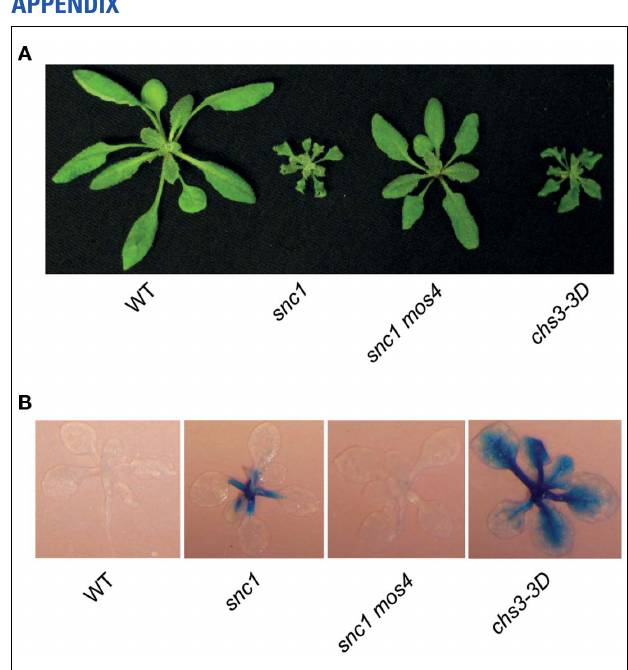
FIGUREA1 | Characterization of chs3-3D . (A) Morphology ofWT, snc1 , snc1 mos4 , and chs3-3D soil-grown plants. Representative plants were photographed 4weeks after germination. (B) Expression of the pPR2 - GUS reporter gene, present inWT and snc1 mutant background, in the above-mentioned genotypes. Seedlings were grown on MS media for 14days prior to staining for GUS activity.The three photographs shown were taken at different magnifications in order to effectively capture GUS staining, thus seedling size should not be compared between